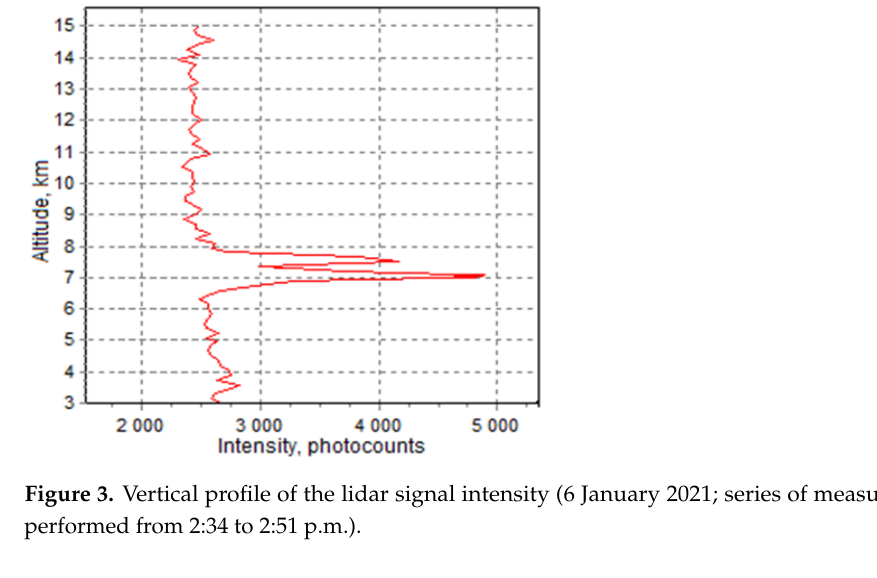
Figure 2. Temporal dynamics of the vertical profile of the lidar signal intensity (6 January 2021; se- ries of measurements was performed from 2:34 to 2:51 p.m.).